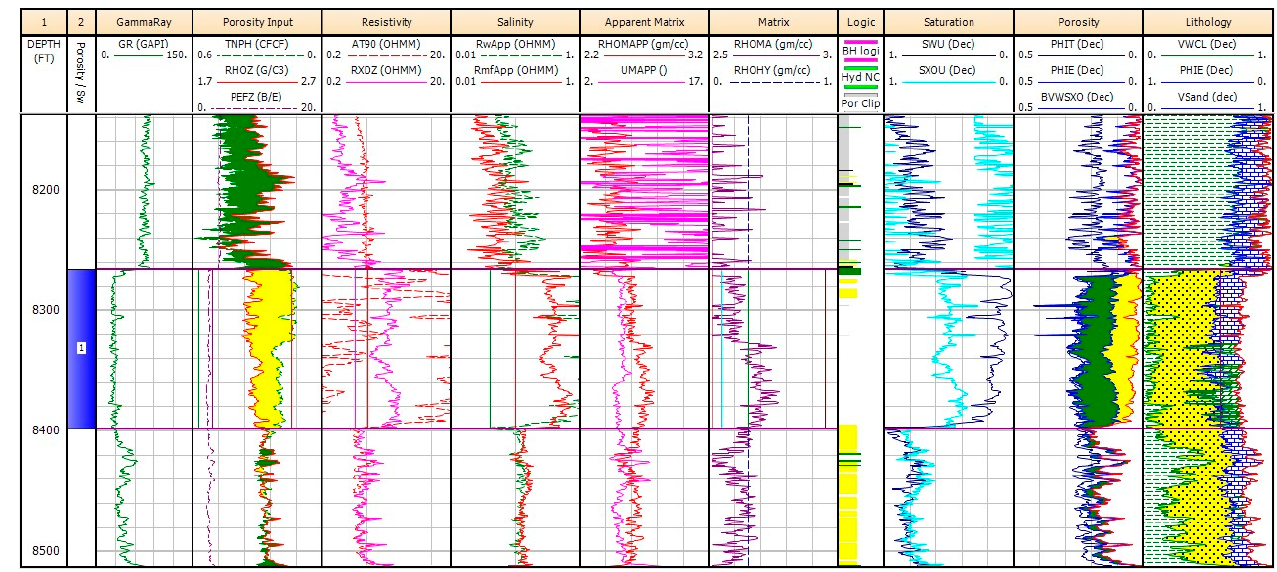
Figure 2. A Triple Combo display for the petrophysical interpretation in well ND-1.